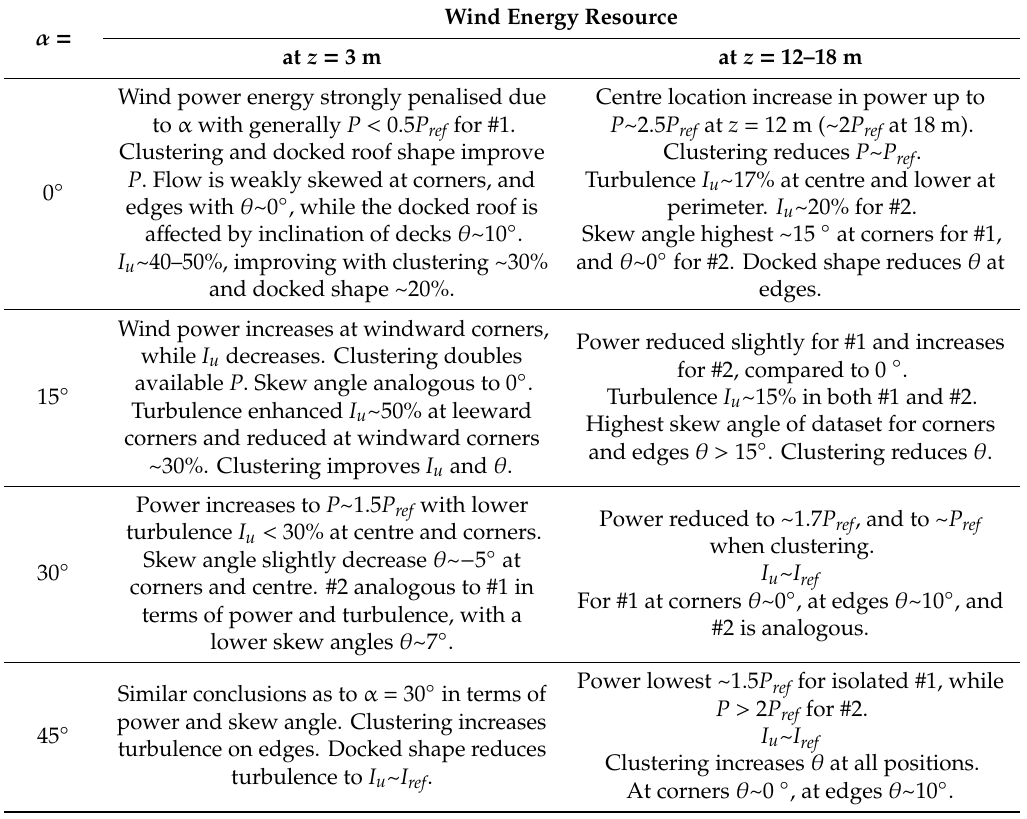
Table 2. E ff ect of wind direction on energy